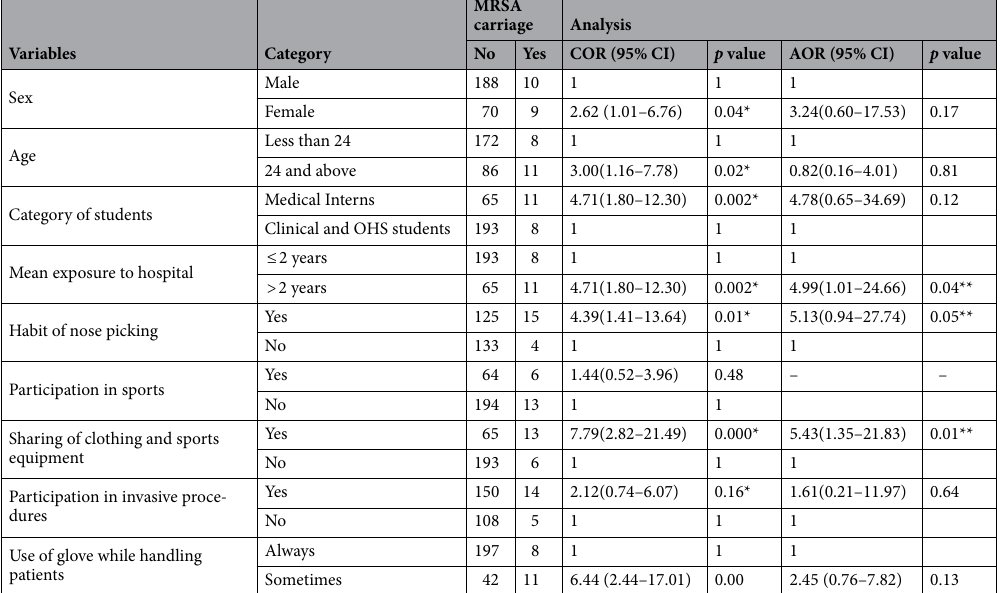
Table 4. Bivariable and multivariable logistic regression analysis of factors associated with nasal carriage of MRSA among Medicine and Health Science Students of Arba Minch University, Arba Minch, southern Ethiopia, 2020. *Statistically significant at p < 0.25 in bivariable analysis; **Statistically significant at p < 0.05 in multivariable analysis, AOR: Adjusted odds ratio, COR: Crude odds ratio, 1: reference group, CI: Confidence